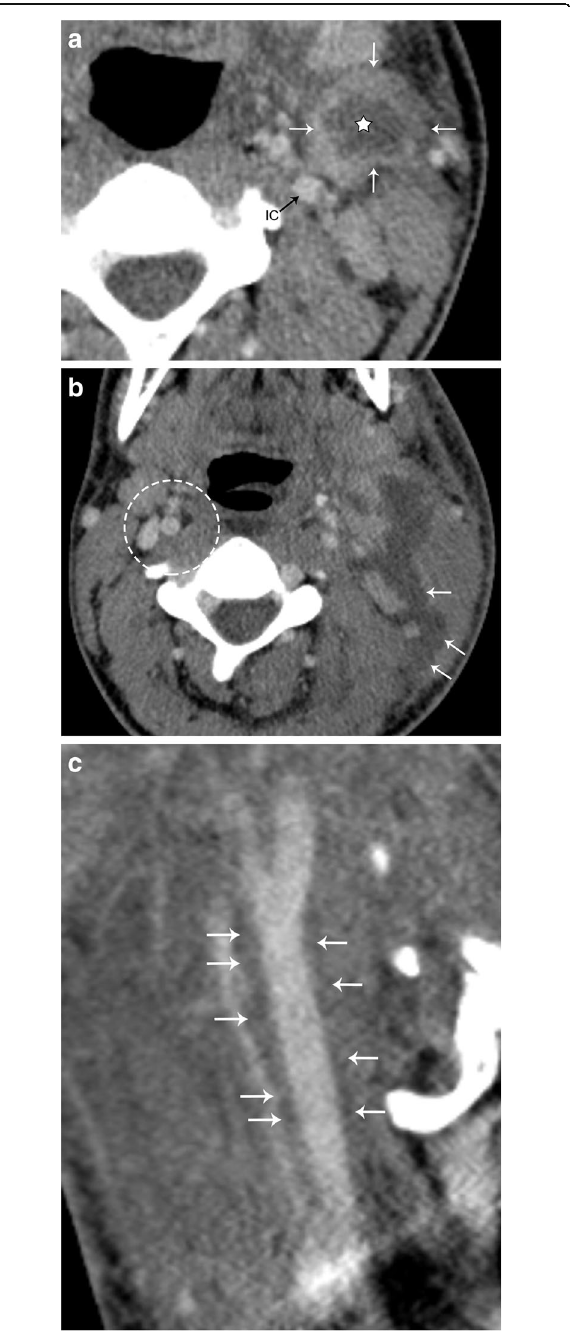
Fig. 19 Suppurative lymph node. Patient presenting with fever, sore throat, cough, and a palpable left neck mass. a Axial contrast- enhanced CT image demonstrates an enhancing left deep cervical chain lymph node (white arrows), with a hypoattenuating center (star). The left internal carotid artery (IC) is medially displaced. b Axial contrast-enhanced CT image 3 days later demonstrates rupture (arrows) of the suppurative node. Note the preserved fat planes in the normal right carotid space (dotted circle). c Sagittal CT image demonstrates fluid tracking along the left carotid space from the lymph node rupture